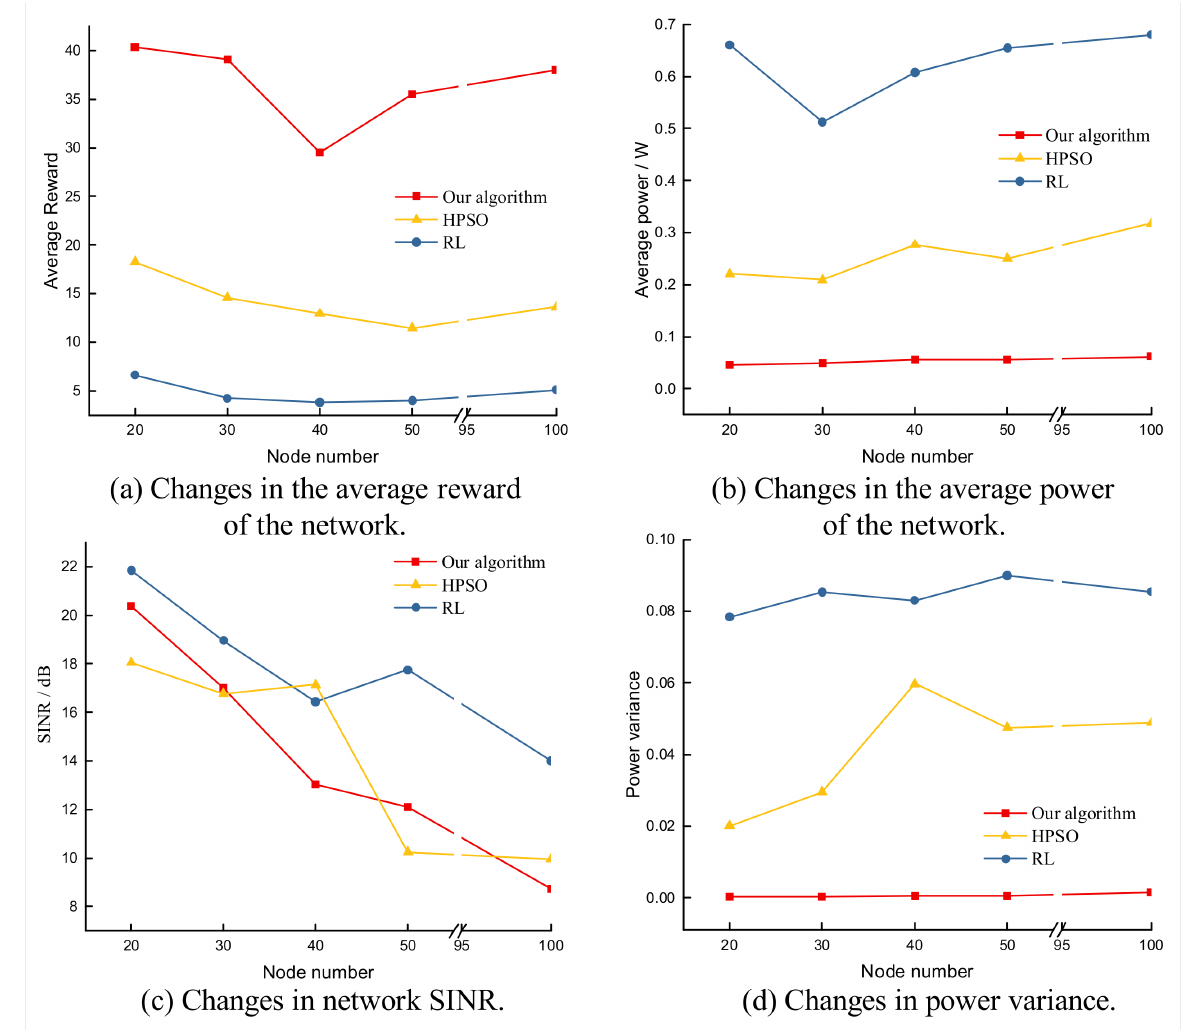
Figure 7. Network performance with different node